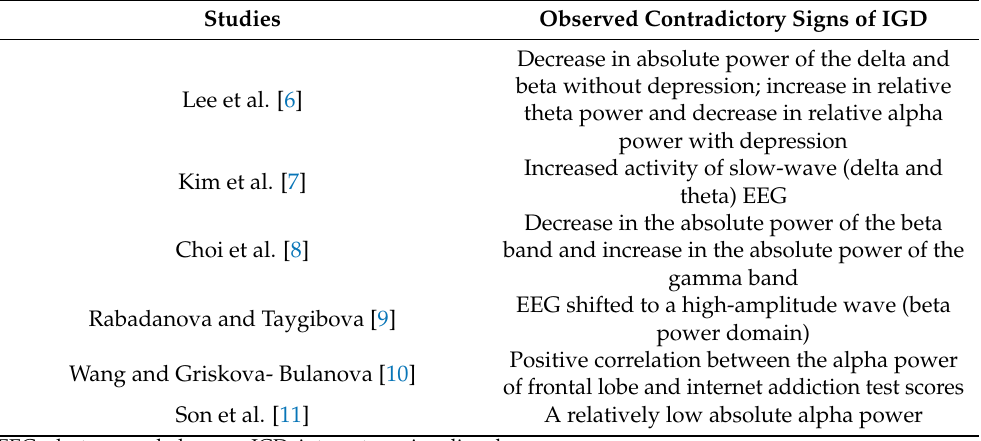
Table 1. Summary of various EEG outcomes associated with presumably IGD subjects. All results were tested during resting state. Studies Observed Contradictory Signs of IGD Decrease in absolute power of the delta and beta without depression; increase in relative Lee et al. [6] theta power and decrease in relative alpha power with depression Increased activity of slow-wave (delta and Kim et al. [7] theta) EEG Decrease in the absolute power of the beta Choi et al. [8] band and increase in the absolute power of the gamma band EEG shifted to a high-amplitude wave (beta Rabadanova and Taygibova [9] power domain) Positive correlation between the alpha power Wang and Griskova- Bulanova [10] of frontal lobe and internet addiction test scores Son et al. [11] A relatively low absolute alpha